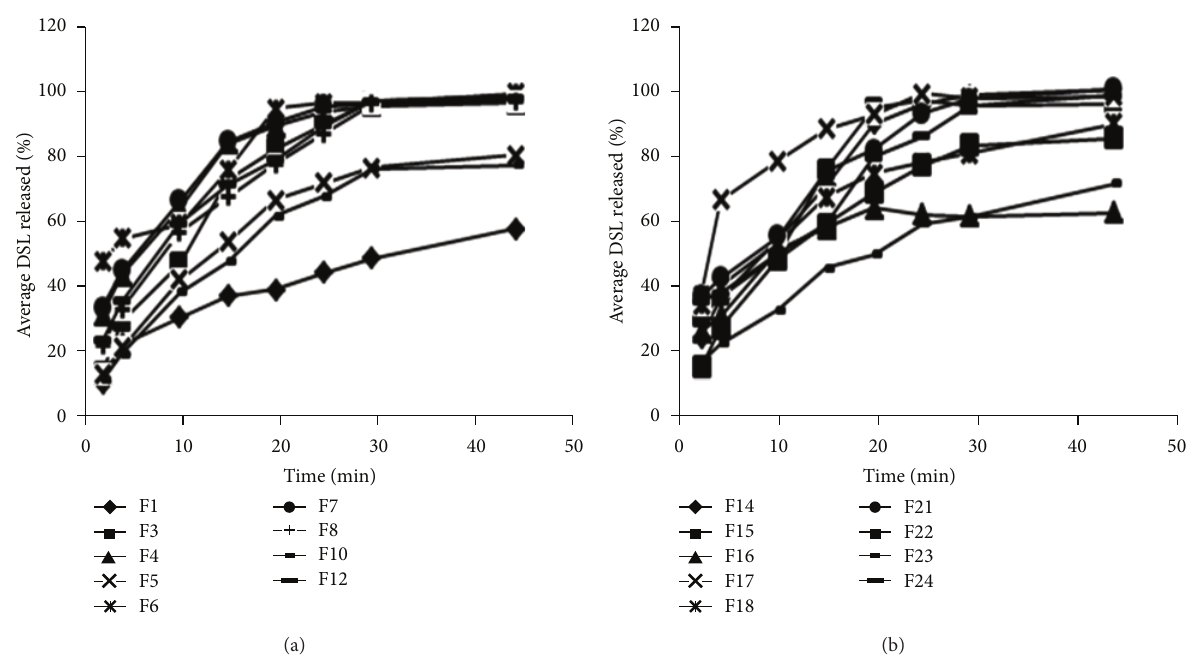
Figure 6: In vitro dissolution test of OS loaded with DSL: (a) formulations containing glycerine and (b) formulations containing PEG 400.